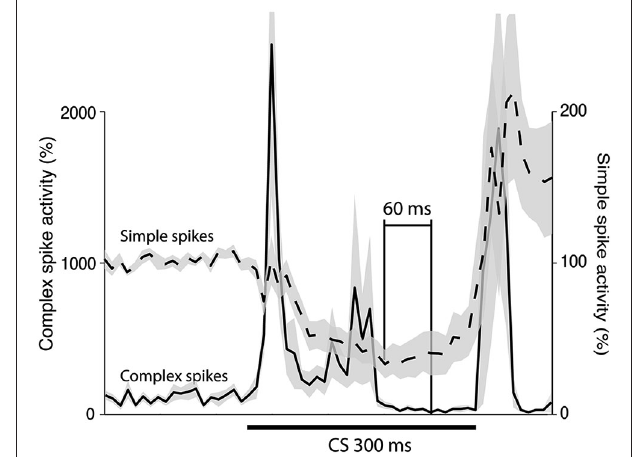
FIGURE 5 | Simple and complex spike activity after training. The plot shows the activity (mean ± SEM) of 12 Purkinje cells in the last 100 trials of acquisition ( n = 8), or in the first 100 trials of extinction ( n = 4). For each cell the data was binned in 10 ms bins and then averaged over all trials. After this had been done for each cell the average profiles illustrated in the figure were constructed. The minimum was defined as the bin with the lowest firing frequency. For the complex spikes there were several bins with zero activity. The minimum in the figure is the earliest of these points.